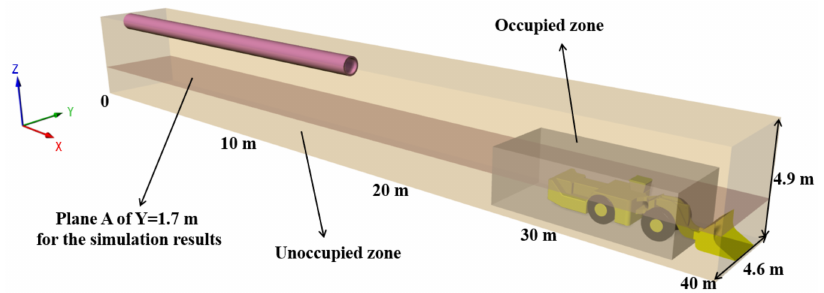
Figure 8. Selection of Plane A and the occupied